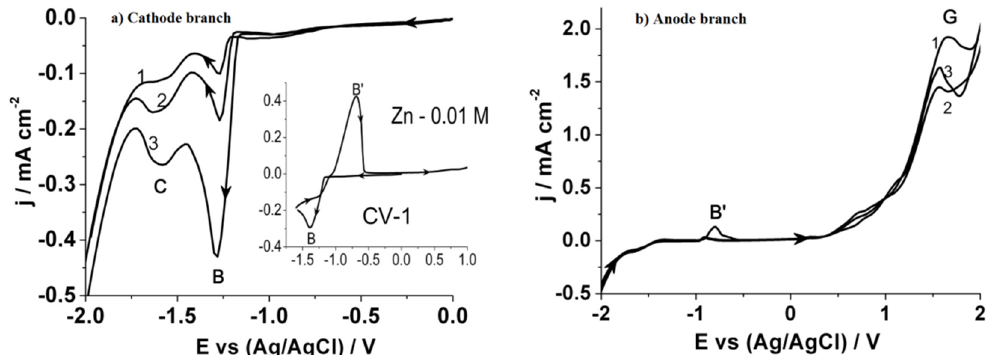
Figure 1. ( a ) Cyclic voltammetry curves of reduction ‐ oxidation of Zn(II); ( b ) Cyclic voltammetry curves of reduction ‐ oxidation of S 2 O 2 − ions. C (Na 2 S 2 O 3 ) = 0.02 М ; C (ZnSO 4 ) : 1 ‐ 0.01, 2 ‐ 0.02, 3 ‐ 0.03 M ( рН = 5.0); (CV ‐ 1) C ZnSO 4 = 0.01M.